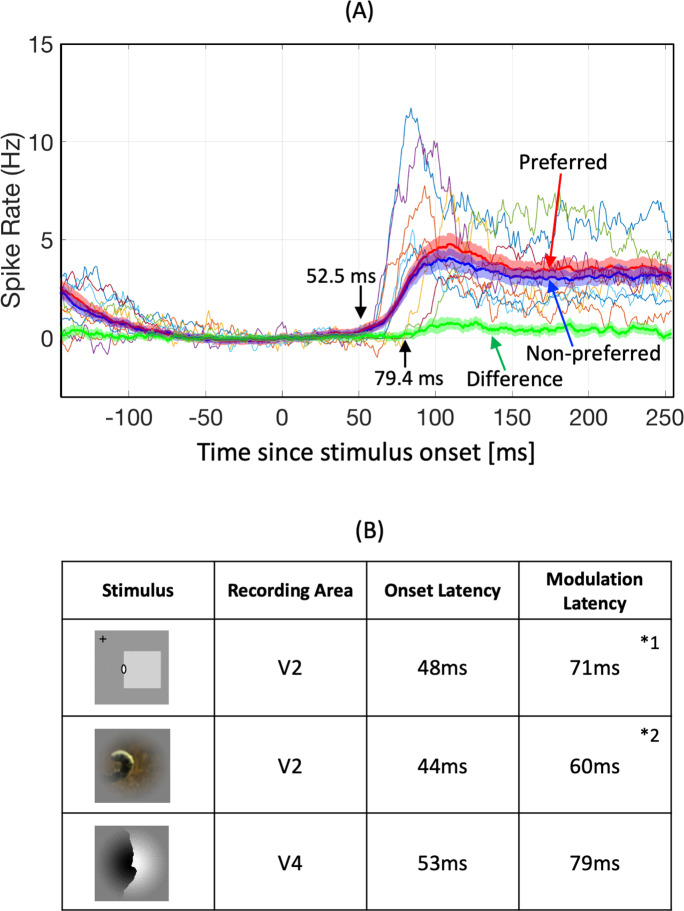
Time course of FG modulation (see “Data analysis” section for details).A: Thin colored lines indicate the example time course of the spike rate across all filled patches presented for 10 example neurons. The mean spike rates across the neurons showing FG significance to filled patches (80 neurons) were calculated separately for the preferred and non-preferred configurations, as shown by the thick red and blue lines, respectively. The subtraction of the two traces as the time course of FG modulation is shown by the thick green line. Shaded error bars indicate SEM. B: Summary of the onset and modulation latencies. The latencies for the border ownership-selective cells reported in previous experiments are also shown for reference (*1: [29]Sugihara et al., 2011, *2: [15]Williford and von der Heydt, 2016).